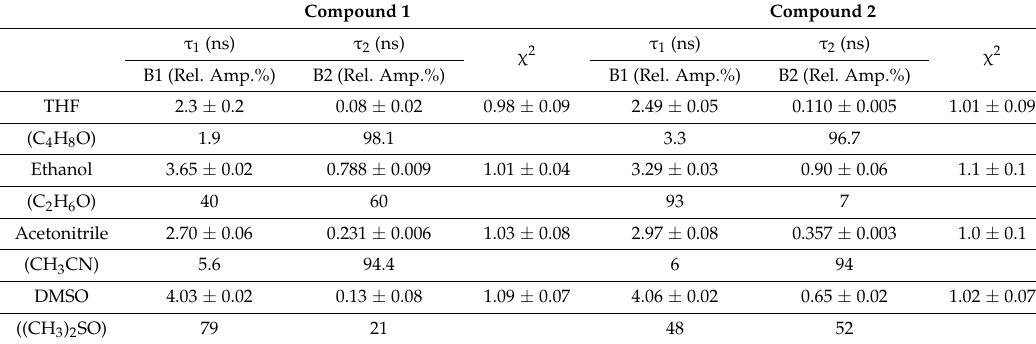
Table 2. Lifetime results for compound 1 and compound 2 in different solvents ( λ e = 460